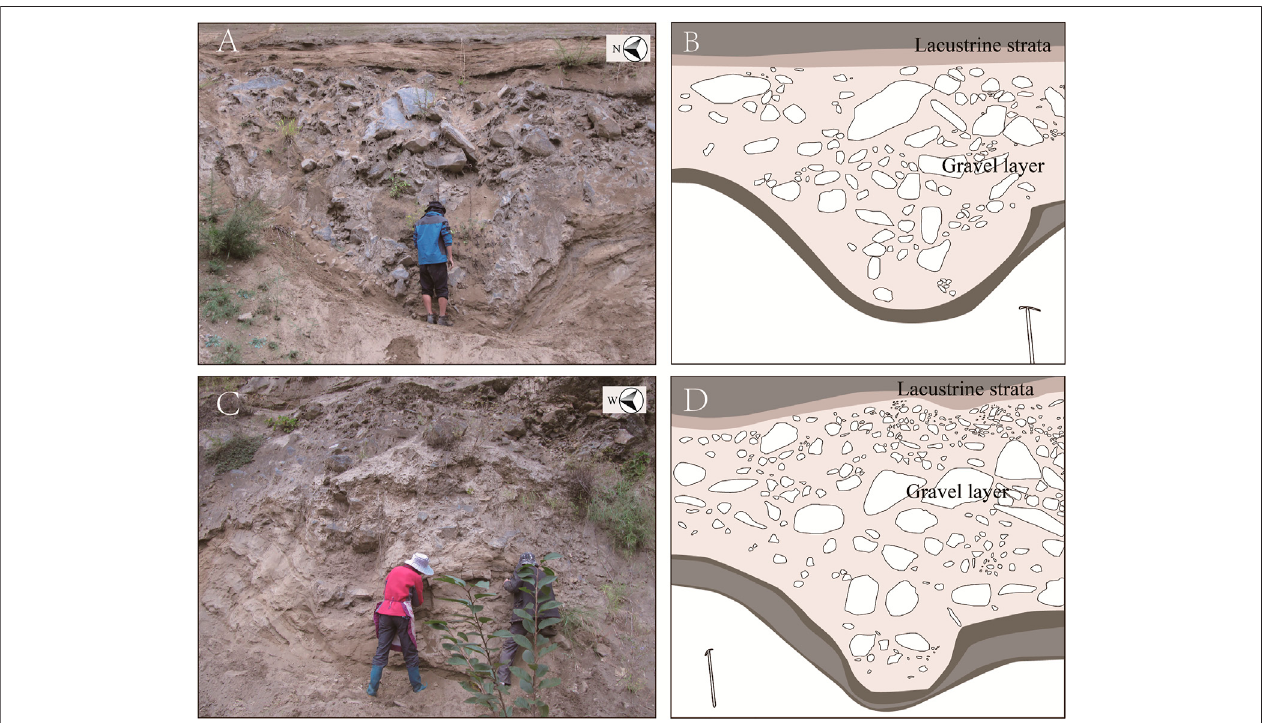
FIGURE4|(A) V-shapedbendingoftheunderlyinglacustrinelayerduetoboulderimpactinthenorthernpartofthesection; (B) SketchoftheV-shapedbendingin the northern part of the section; (C) V-shaped bending of the underlying lacustrine layer due to boulder impact in the middle part of the section; (D) Sketch of the V-shaped bending in the middle part of the